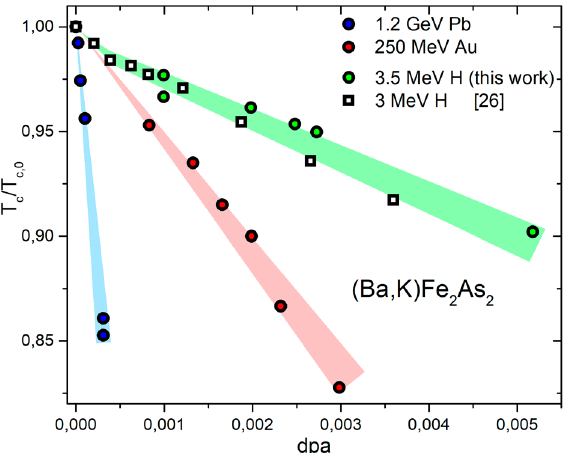
Figure 2. Critical temperature degradation as a function of the amount of introduced defects in terms of dpa for different ion-energy combinations on the same type of IBS (optimally doped Ba 1 − x K x Fe 2 As 2 ). Data for 3 MeV H irradiation (white squares) are taken from Ref. 26 and obtained by low temperature irradiation and in-situ dc resistivity measurement.